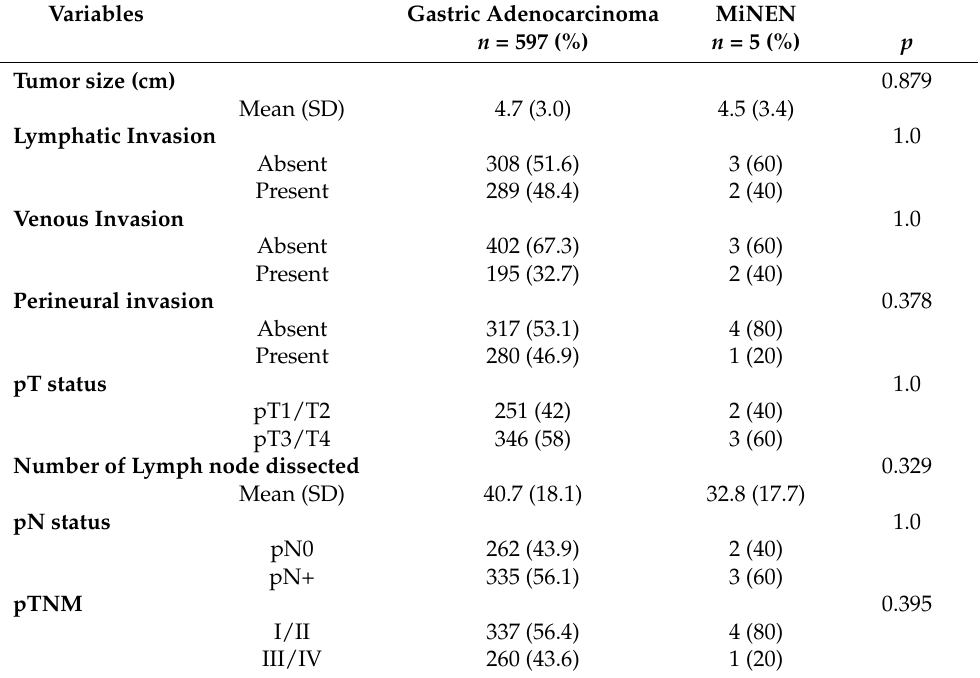
Table 2. Pathological characteristics of patients with gastric adenocarcinoma and MiNEN.